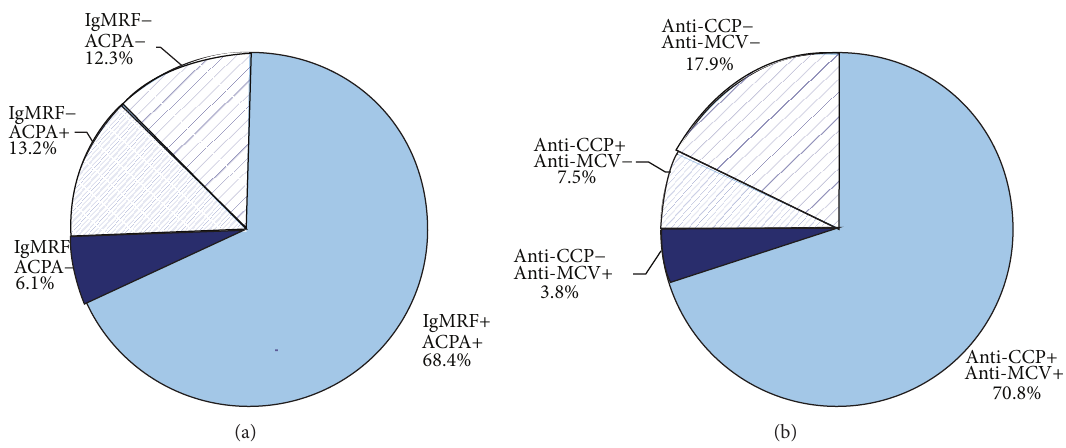
Figure 1: Dividing patients into groups, depending on the level of antibodies; “+”: high-positive level and “ − ”: negative/low positive level.